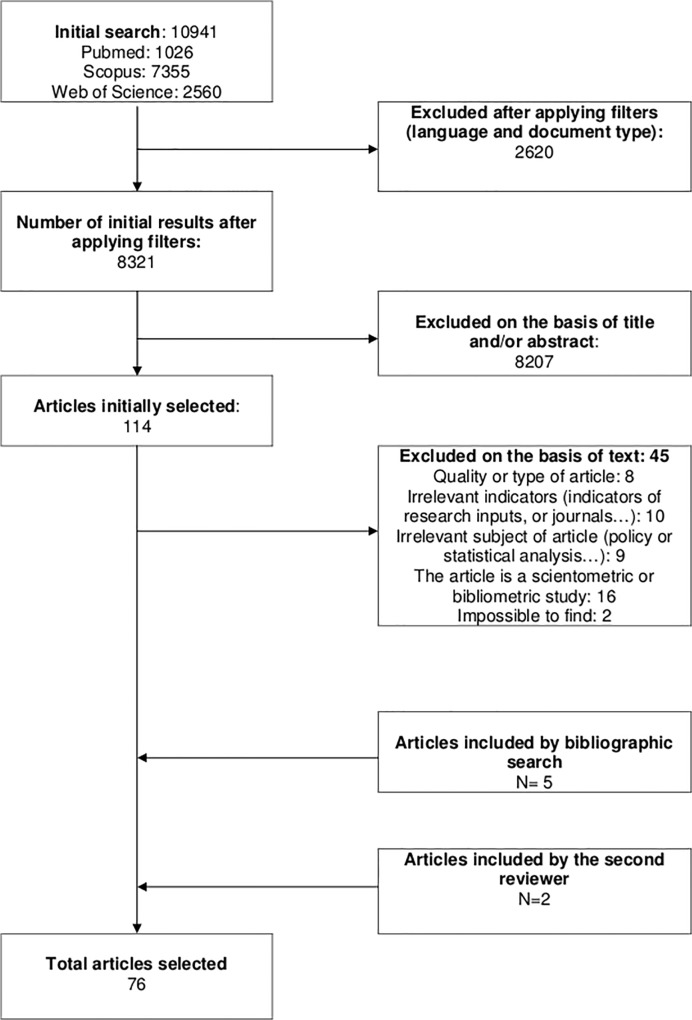
PRISMA flowchart.